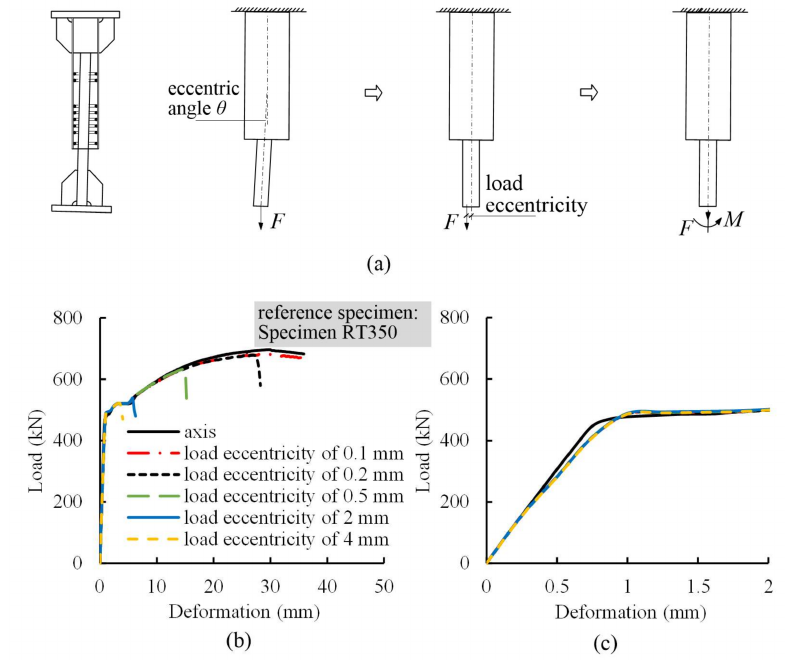
Figure 21. ( a ) Misalignment of steel profile; ( b ) load-deformation curves for specimen with di ff erent load eccentricities using FEM models; and ( c ) elastic parts of these